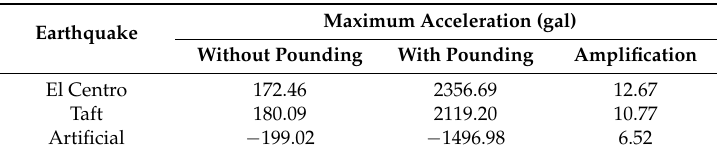
Table 5. Maximum acceleration values for model B.